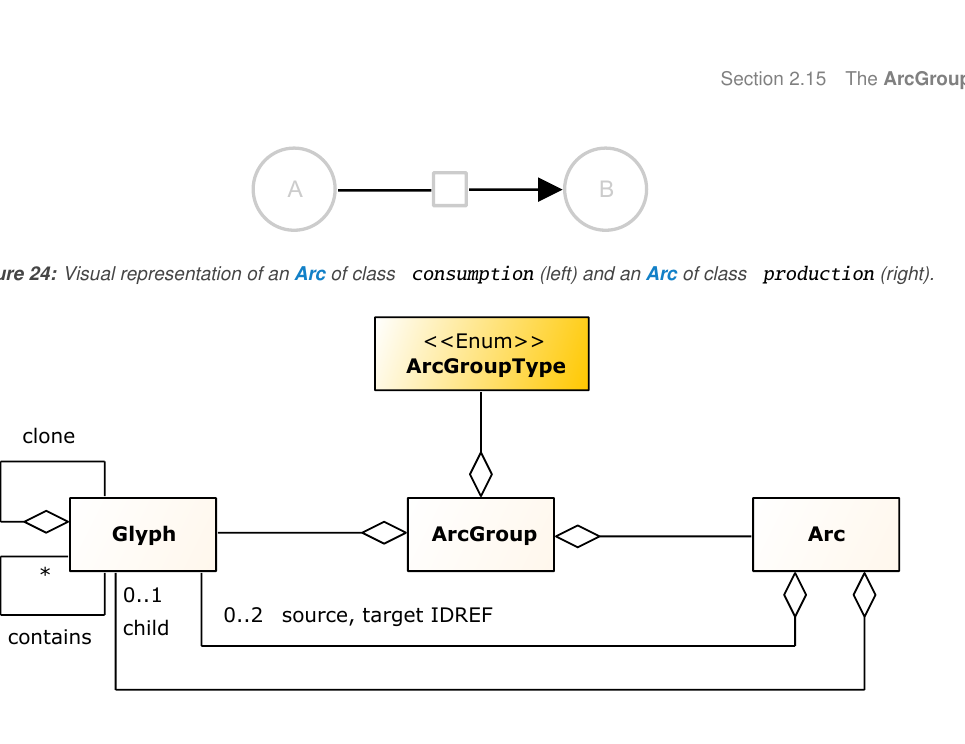
Figure 25: A UML representation of the ArcGroup class for the Systems Biology Graphical Notation - Markup Language. See Section 2.1 for conventions related to this